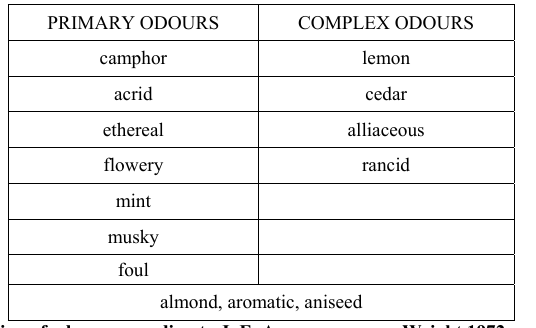
Fig. 2. Classification of odours according to J. E. Amoore, source: Wright 1972, p.